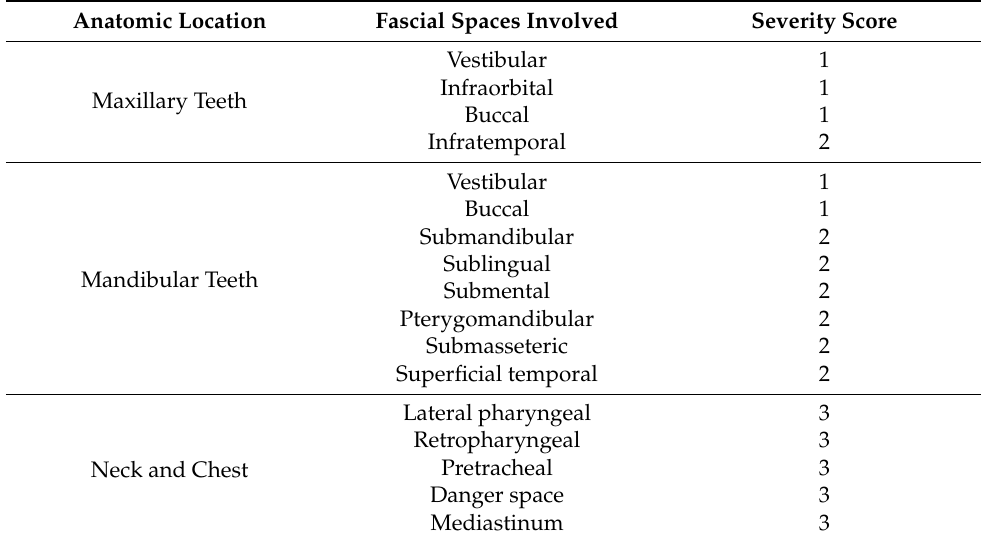
Table 1. Fascial spaces involved in severe odontogenic infections based on anatomical location with associated severity score developed by Flynn et al.